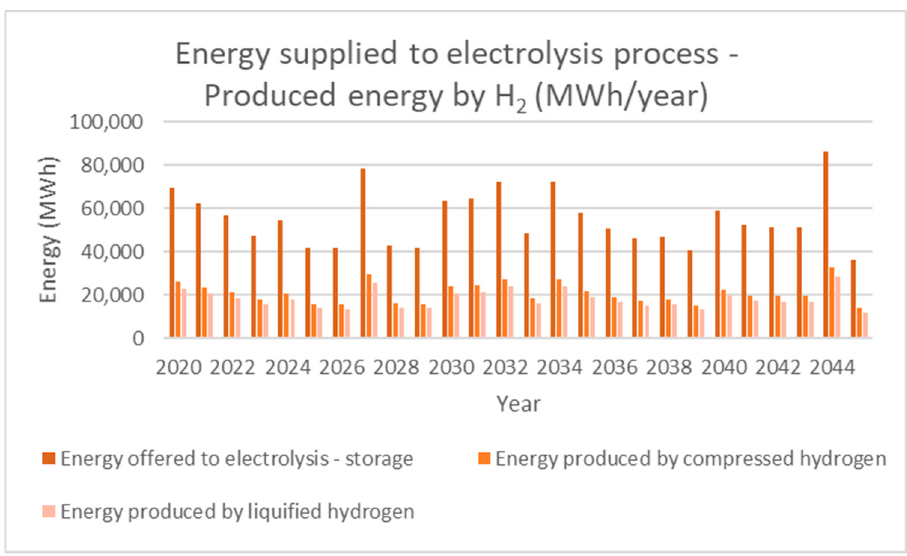
Figure 15. Energy supplied to electrolysis process—energy produced by H 2 .